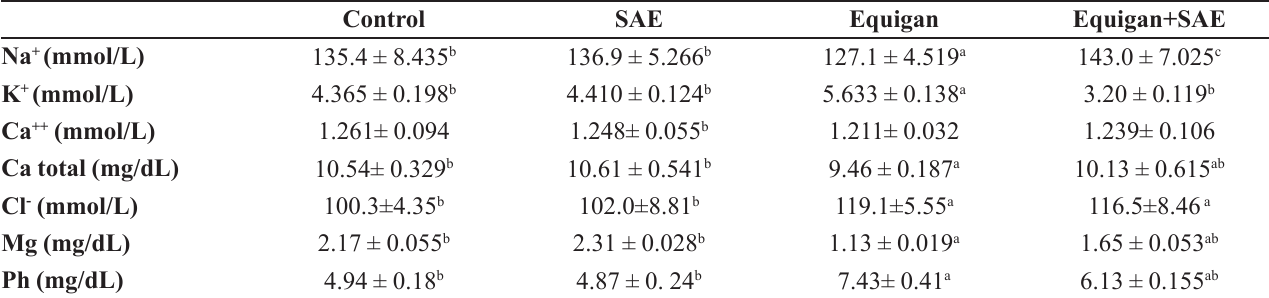
TABLE II - Changes in electrolyte levels in different groups